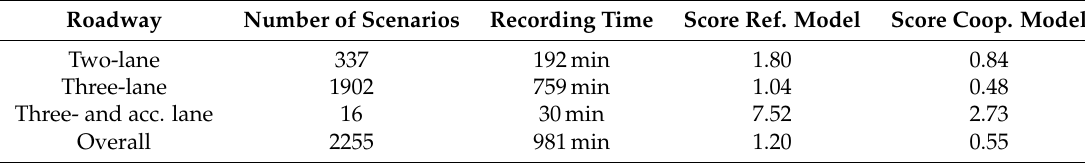
Table 2. Structure of the test scenario